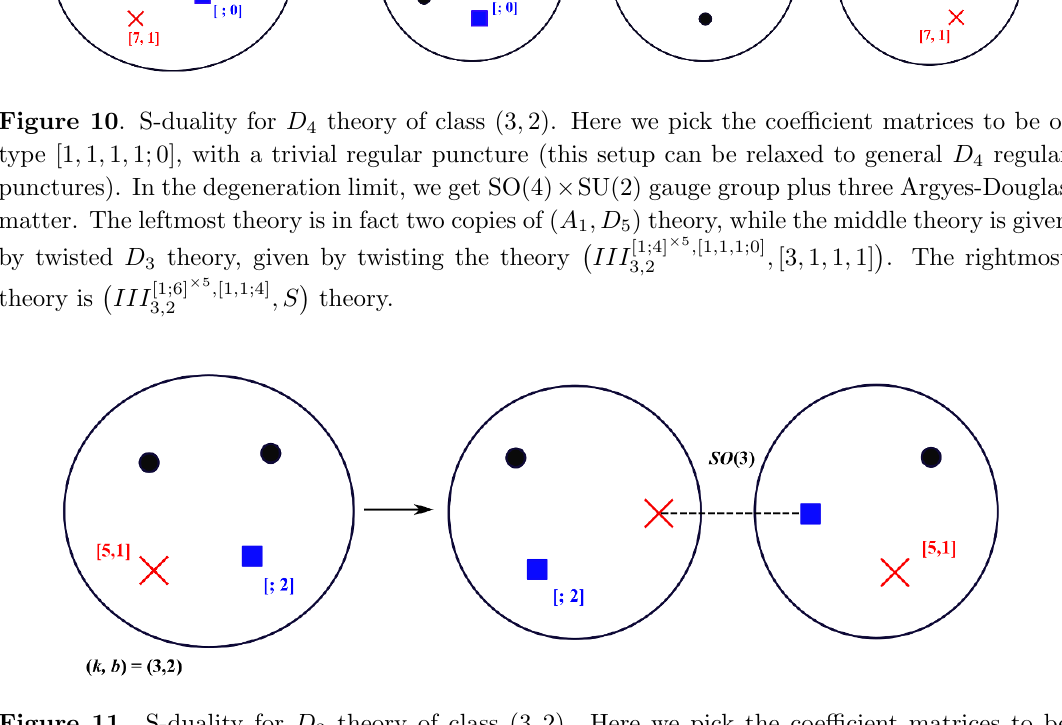
Figure 11 . S-duality for D 3 theory of class (3 ; 2). Here we pick the coe(cid:14)cient matrices to be of type [1 ; 1; 2], with a trivial regular puncture (this setup can be relaxed to general D 3 regular